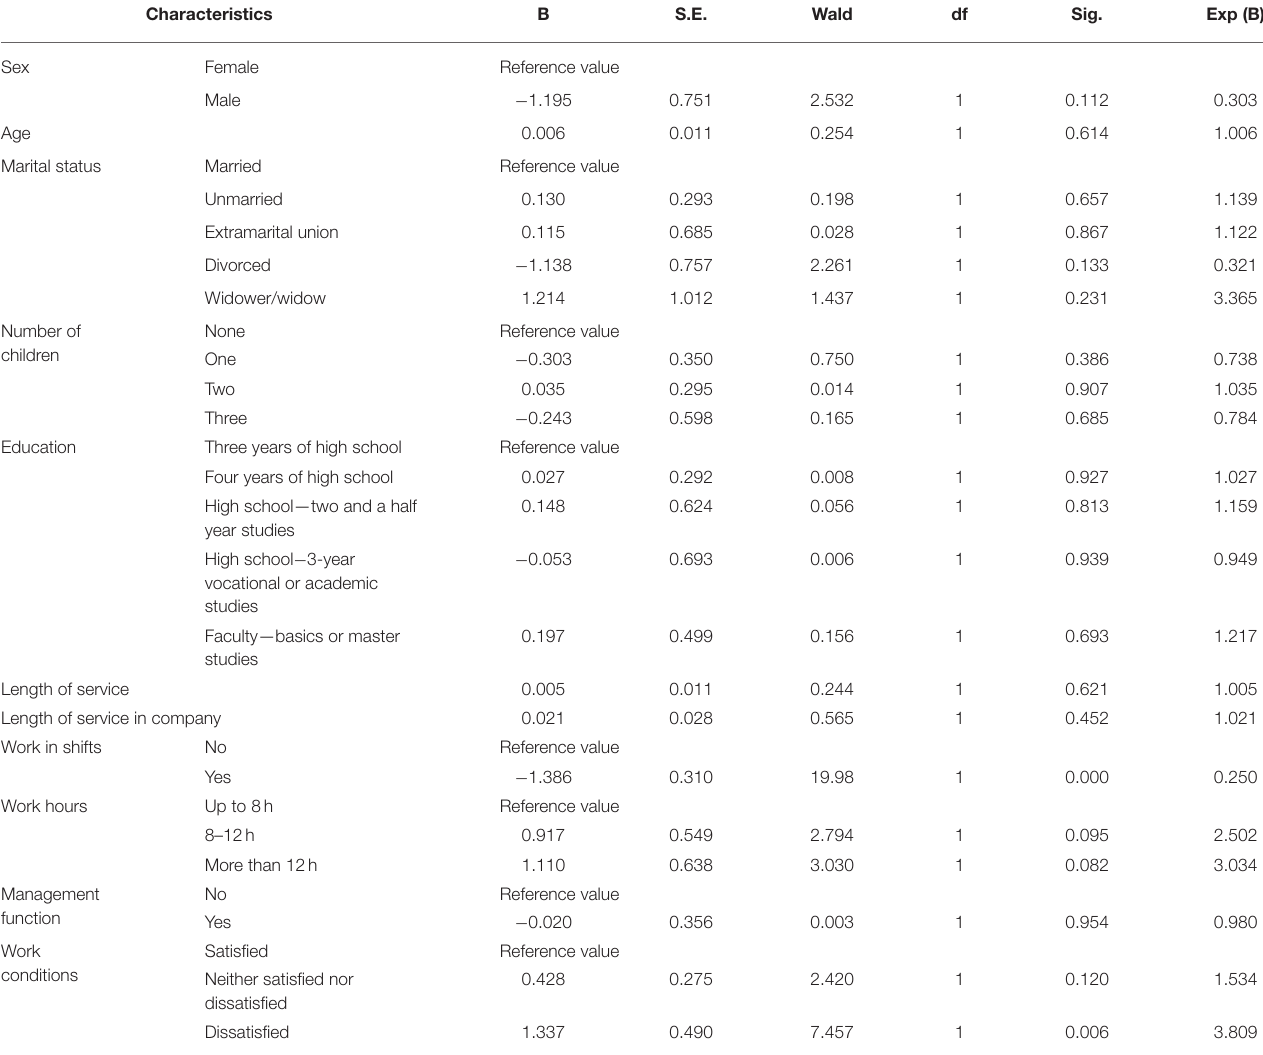
TABLE 7 | Factors affecting the Total Burnout: results of multiple regression analysis.